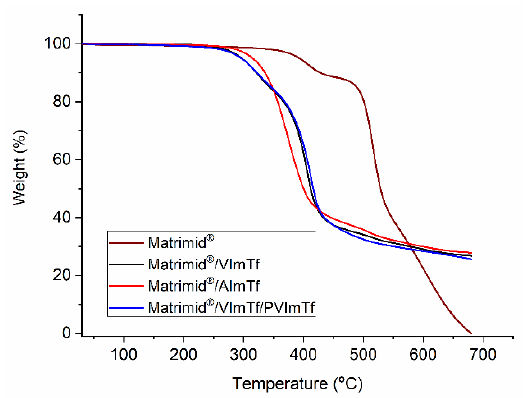
Figure 6. Thermogravimetrical curves of pure Matrimid ® and elaborated SILMs.